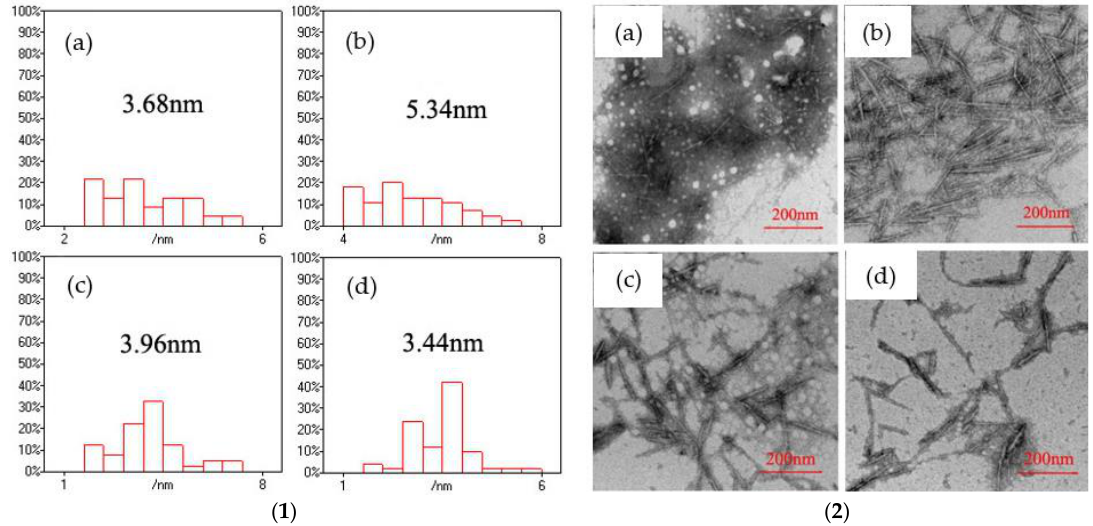
Figure 8. ( 1 ) The size distributions of the CdS nanoparticles with different maturing time; and ( 2 ) the TEM images of CNF/CdS nanocomposites with different maturing time; ( a ) 40 min; ( b ) 60 min; ( c ) 80 min; and ( d ) 100 min (–COOH/Cd 2+ ratio 1.0, Na 2 S feeding time 20